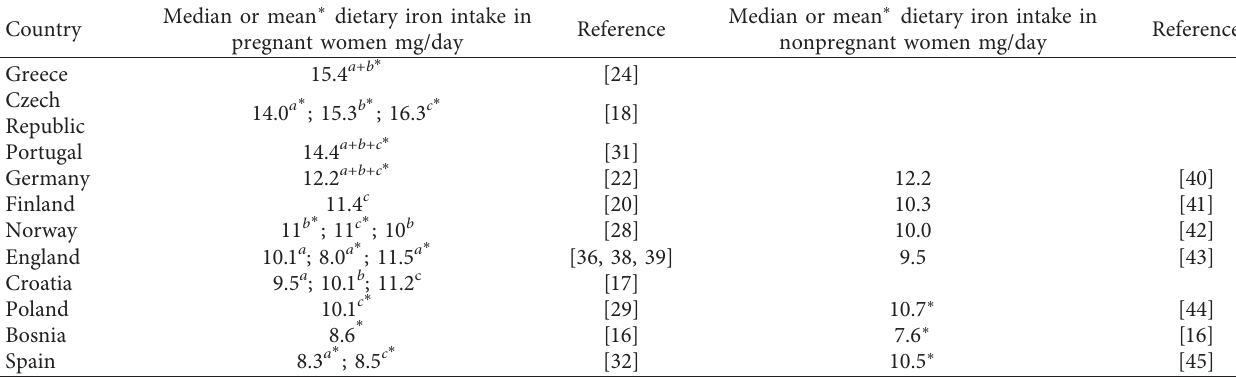
Table 2: Dietary iron intake in pregnant women in 11 European countries arranged according to the magnitude of median or mean iron intake. For comparison, iron intake in nonpregnant women of reproductive age in the same countries is shown as well. Only studies using dietary record methods are included.